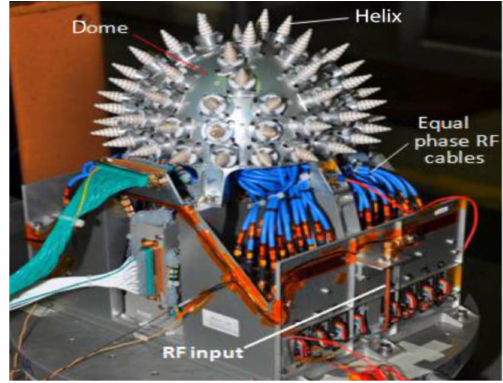
Figure 1. A connected 64-element SAA in anechoic chamber